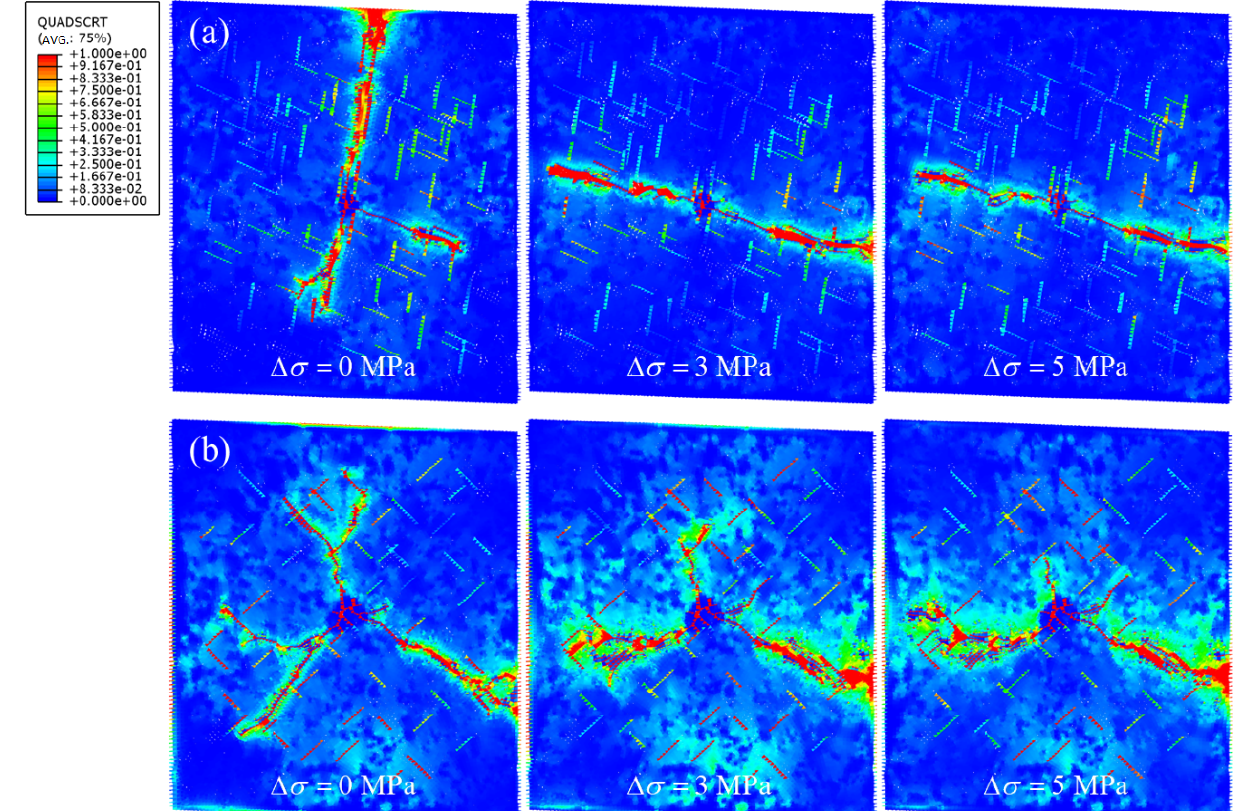
Figure 9. Fracture criterion distributions of group A ( a ) and group B ( b ) under different ground stress differences. First line in subfigures represent the results of natural fracture group A and second line is group